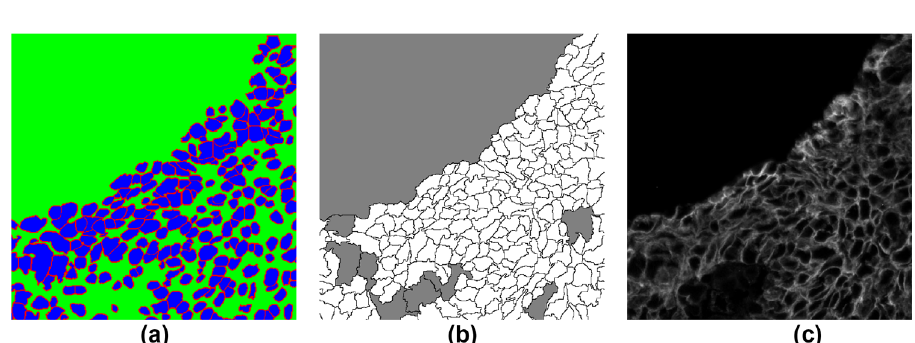
Figure 3. ROI sample (from weak-label-set ) for cell label generation. ( a ) Nucleus label map in which each nucleus was used as a marker for performing marker-controlled watershed + morphological operations to generate a cell label map ( b ). Color codes in ( b ): white—inner cell regions, black—cell boundaries, and grey— background. ( c ) MEM channel